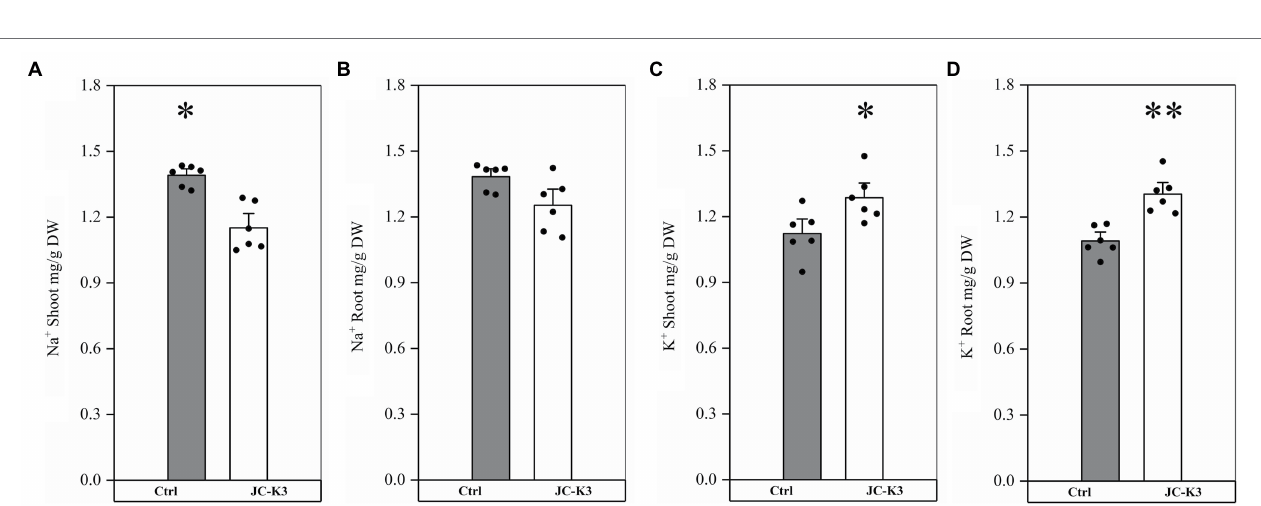
FIGURE 2 | Effect of inoculation isolate JC-K3 on (A) total soluble sugar (TSS), (B) proline, and (C) total chlorophyll content. Each value is the average of six replicates. The error bar represents the SE the average of six replicates. * on the bar chart of each treatment indicates the significant difference between the control group and the treatment group, * p < 0.05; ** p < 0.01 (Student’s t -test). The black and white columns represent the control (Ctrl) and JC-K3 inoculated plants, respectively.